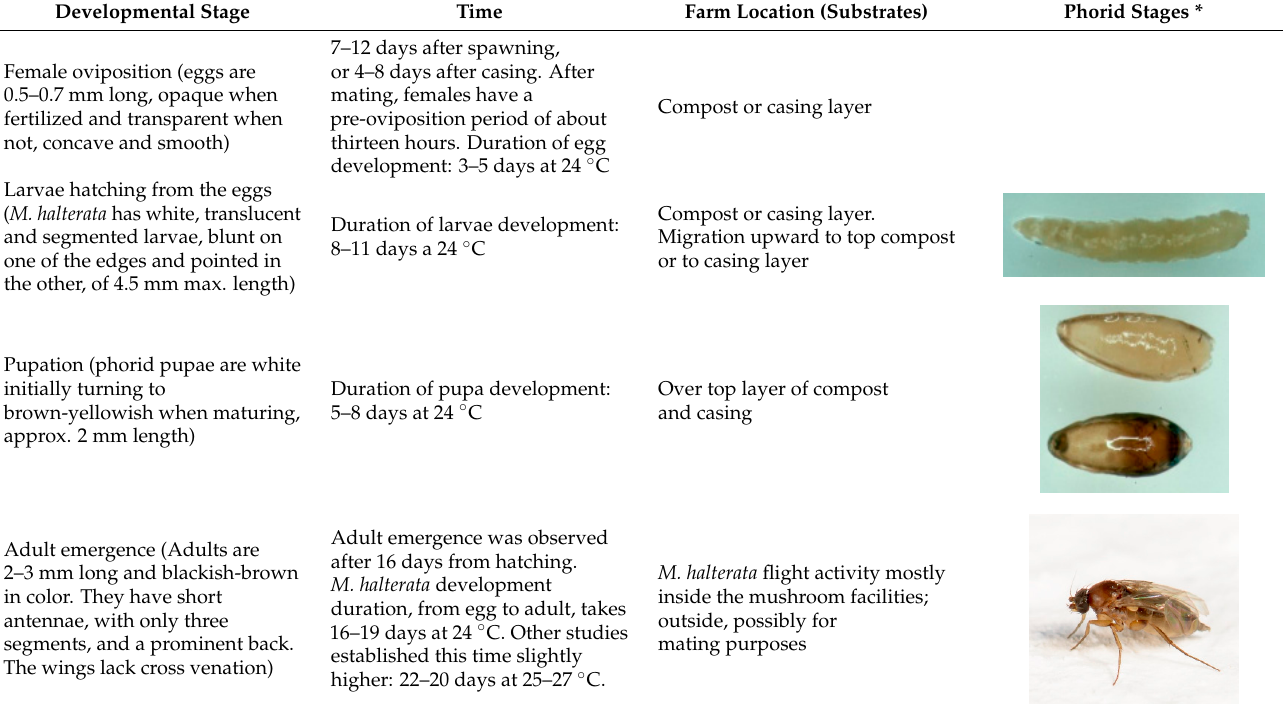
Table 1. Biology of mushroom phorid flies associated with mushroom crops.